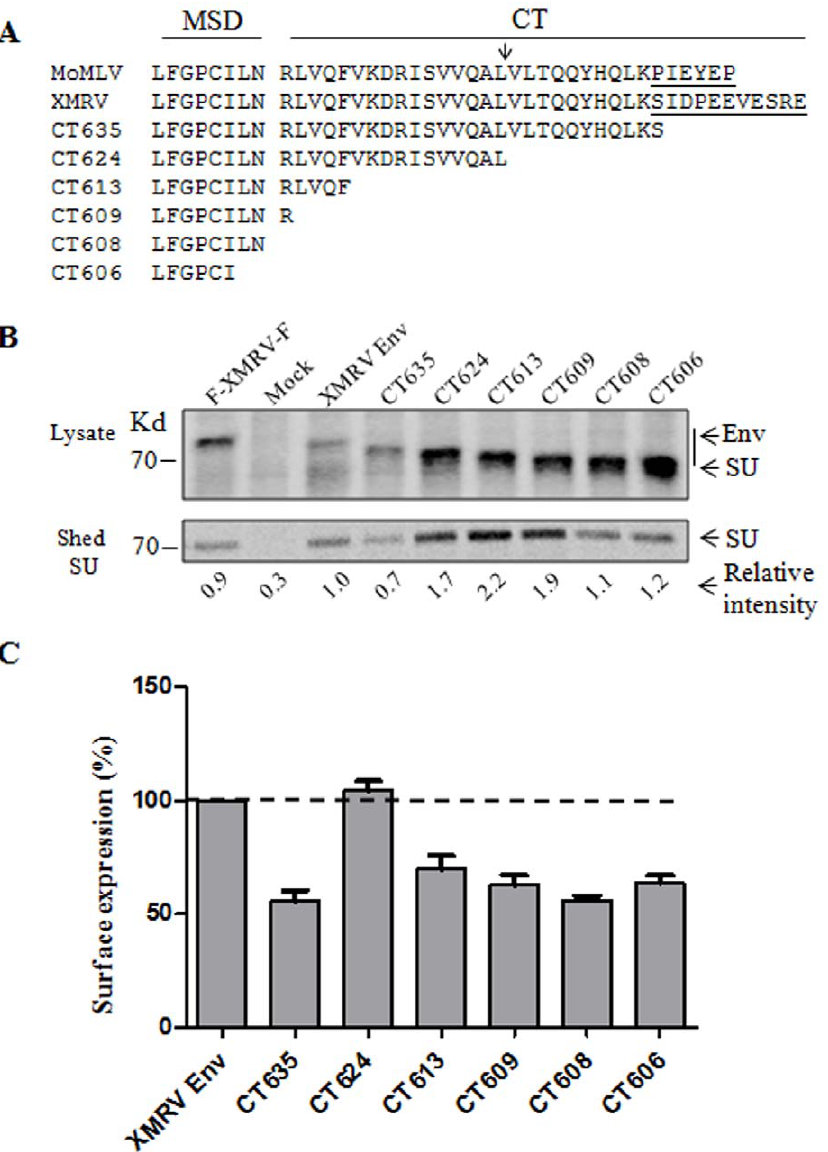
Figure 3. C-terminal truncation of XMRV Env induces SU shedding. (A) Sequence alignment of MoMLV and XMRV Env constructs. MSD: membrane spanning domain. CT: cytoplasmic tail. Arrow: indicates the MoMLV Env R-peptide cleavage site. Underlined: The CT region that differs between XMRV and MoMLV. (B) 293T cells expressing XMRV Env were metabolically labeled for 1 h and chased for 4 h. Env proteins in cells lysates and shed in the culture media were immunoprecipated, resolved by SDS-PAGE and subjected to autoradiography. Band density was measured using the Quantity One software and values were normalized to the intensity of the XMRV Env SU set to 1.0. Representative experiment is shown (n=2). (C) The expression of XMRV Env on the 293T cell surface was measured using anti-FLAG and flow cytometry. Fluorescence geometric means were normalized to XMRV Env (100%). Shown are the averages of 3 independent experiments 6 S.D. XMRV Env: XMRV Env tagged with a FLAG sequence only at the N-terminus. All truncations were also tagged similarly with an N-terminal FLAG. F-XMRV-F: an XMRV Env construct that is tagged by FLAG sequences on both N- and C-termini. Mock: untransfected 293T cells.